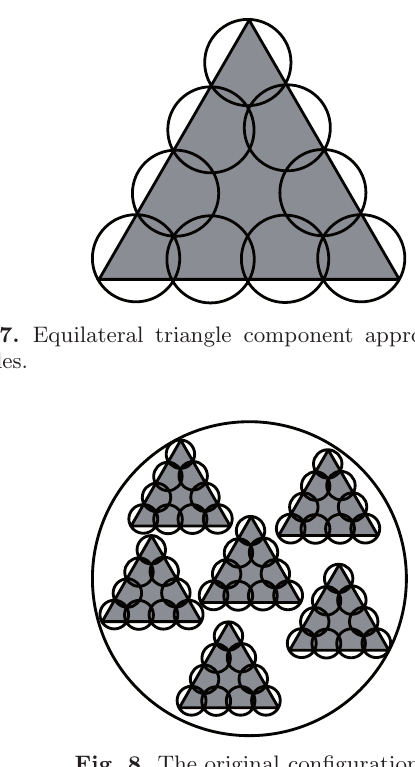
Fig. 8. The original